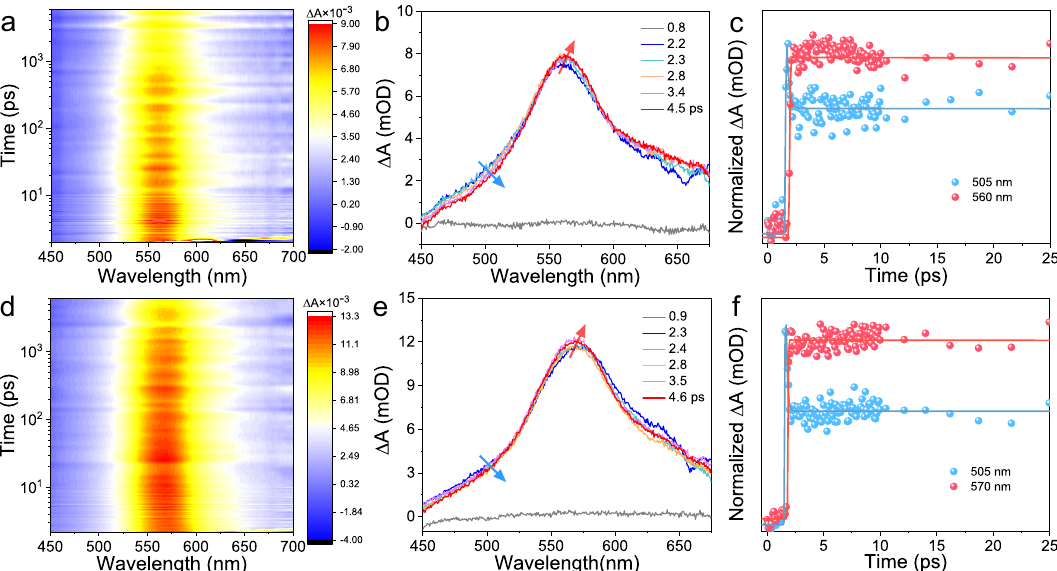
Fig. 4 Femtosecond transient absorption measurements. a Two-dimensional femtosecond transient absorption (fs-TA) spectra of Au 22 (SG) 18 NCs. b fs- TA spectra of Au 22 (SG) 18 NCs at short time delays. c Kinetic traces and fi tting lines of Au 22 (SG) 18 NCs at 505 and 560 nm. d Two-dimensional fs-TA spectra of PDA-Au 22 (SG) 18 NCs. e fs-TA spectra of PDA-Au 22 (SG) 18 NCs at short time delays. f Kinetic traces and fi tting lines of PDA-Au 22 (SG) 18 NCs at 505 and 570 nm.